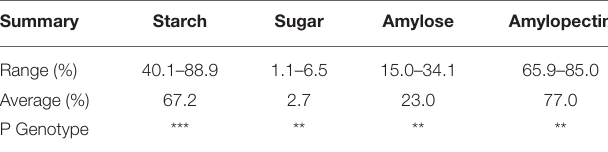
TABLE 2 | Phytate and tannin levels of Striga -resistant yellow-orange maize hybrids grown at Zaria and Saminaka ( N = 64). Variable